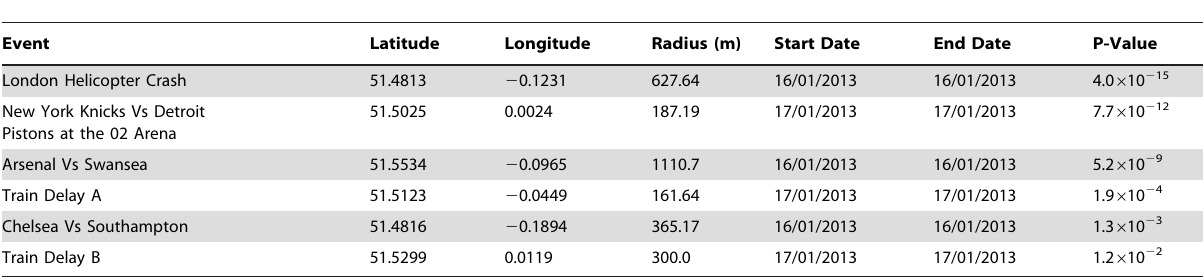
Table 5. Identified daily cluster attributes derived via space-time scan